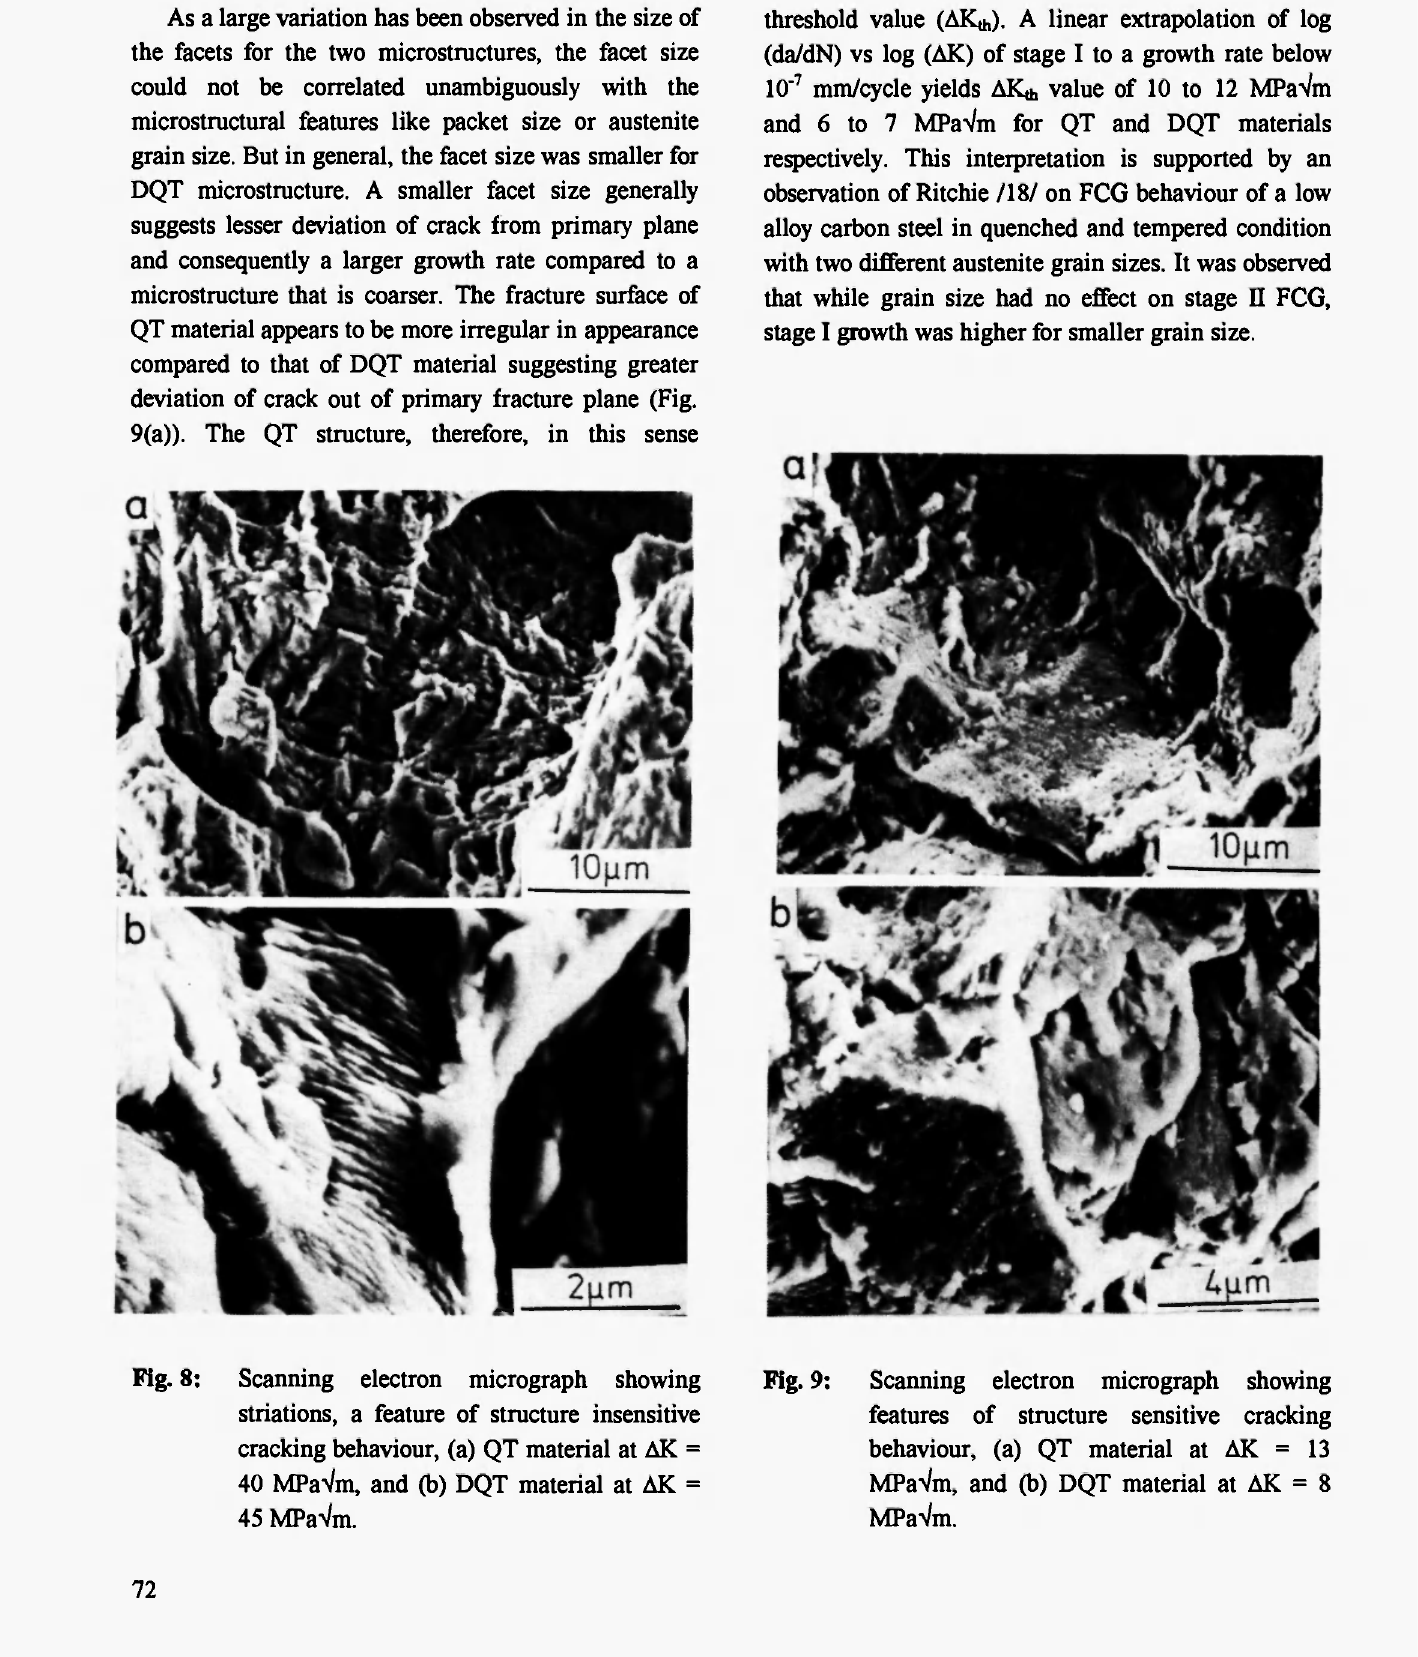
Fig. 9: Scanning electron micrograph showing features of structure sensitive cracking behaviour, (a) QT material at ΔΚ = 13 MPaVm, and (b) DQT material at ΔΚ = 8